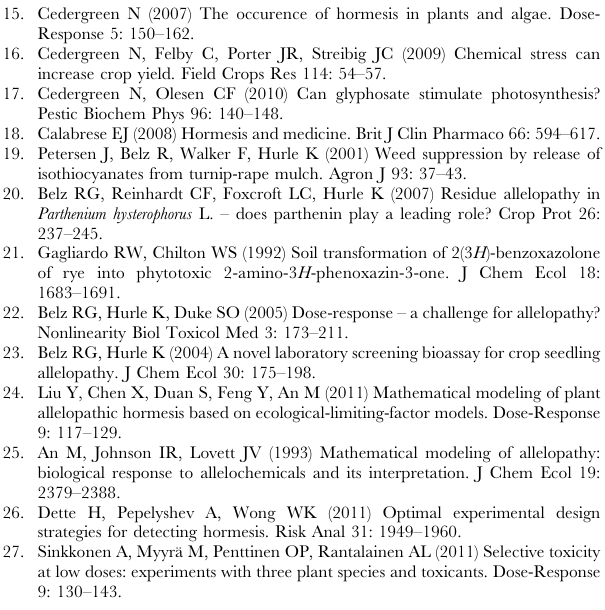
Table S1 Syntax for parameterizations of the Brain and Cousens model [ 9 ] after Schabenberger et al. [ 10 ] . Table S2 Syntax for parameterizations of the Ceder- green et al. model [ 2 ] . Table S3 Regression Parameters for curves displayed in Figure 1.